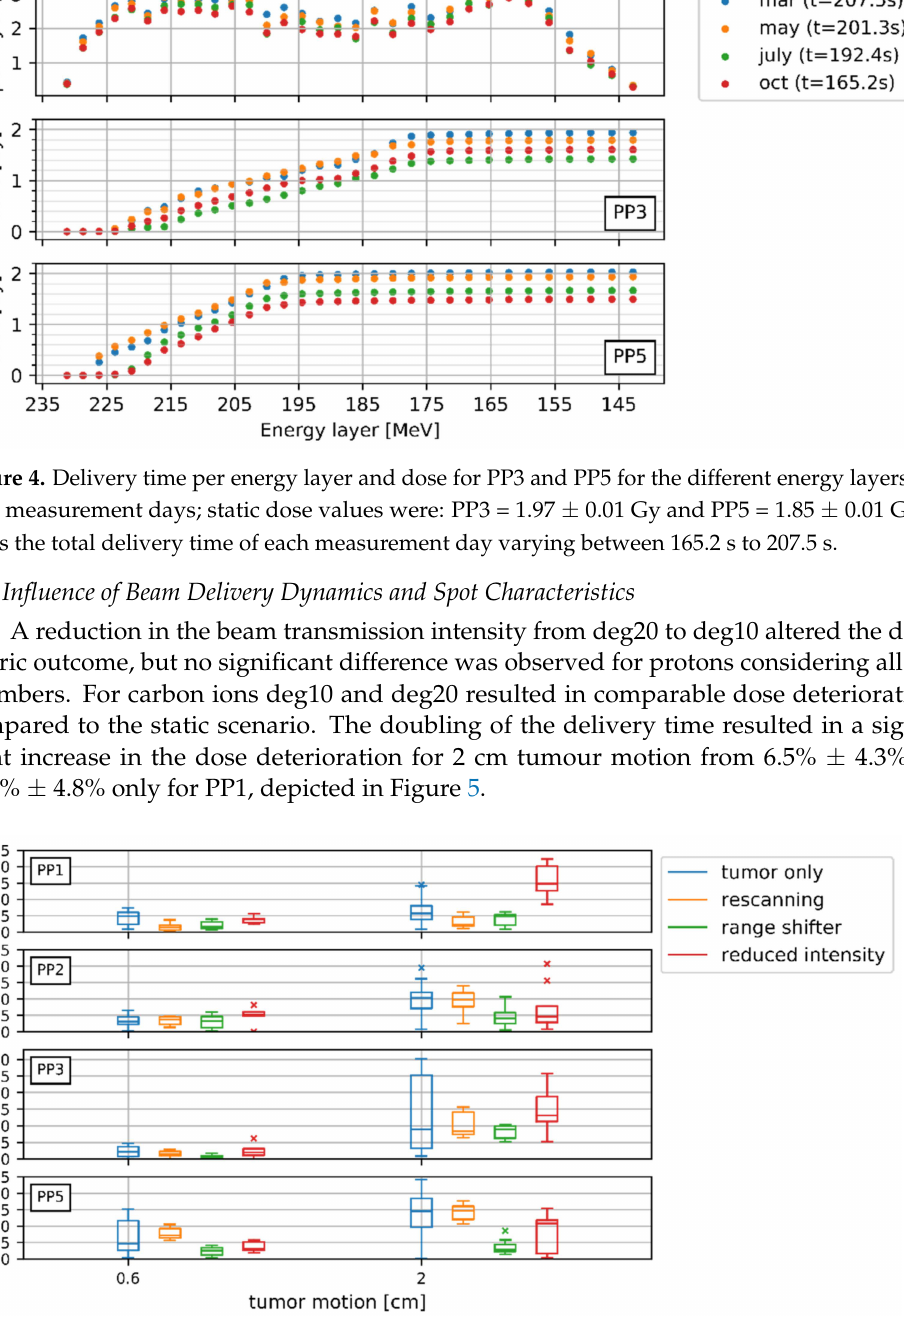
Figure 5. Boxplots containing the deviation from the static dose for different motion scenarios (tumour motion of 0.6 and 2 cm) for carbon ion irradiations with different motion mitigation techniques. The rescanned treatment plan consisted of a mixture of beam transmission